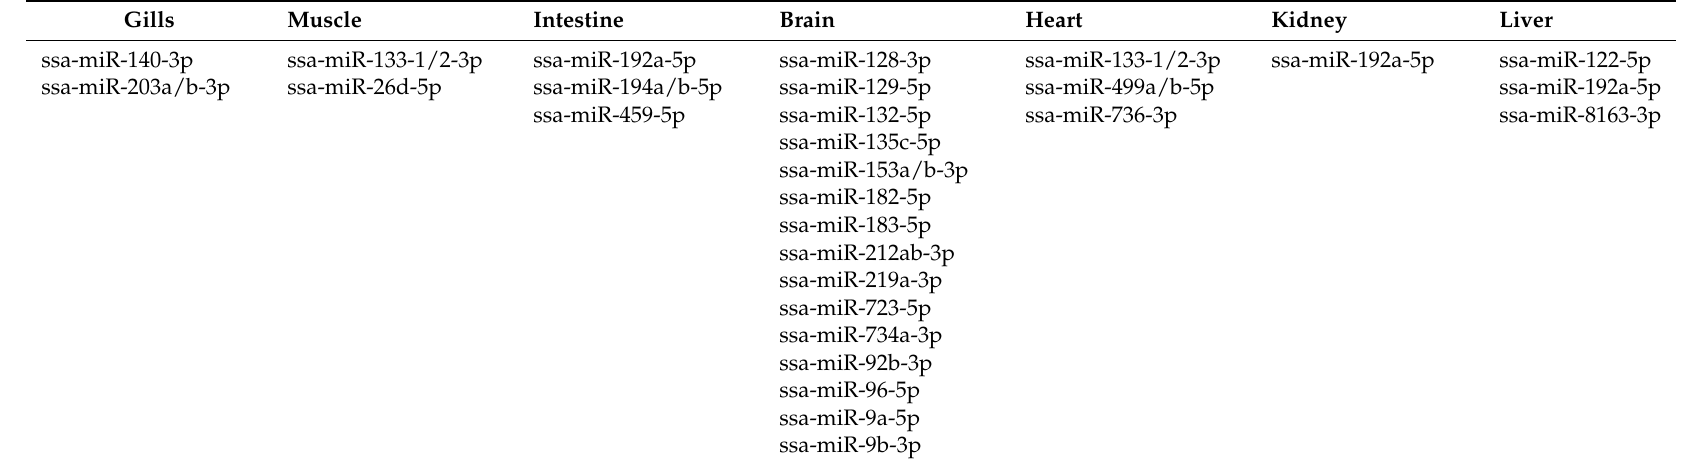
Table 4. miRNAs that show tissue enriched expression